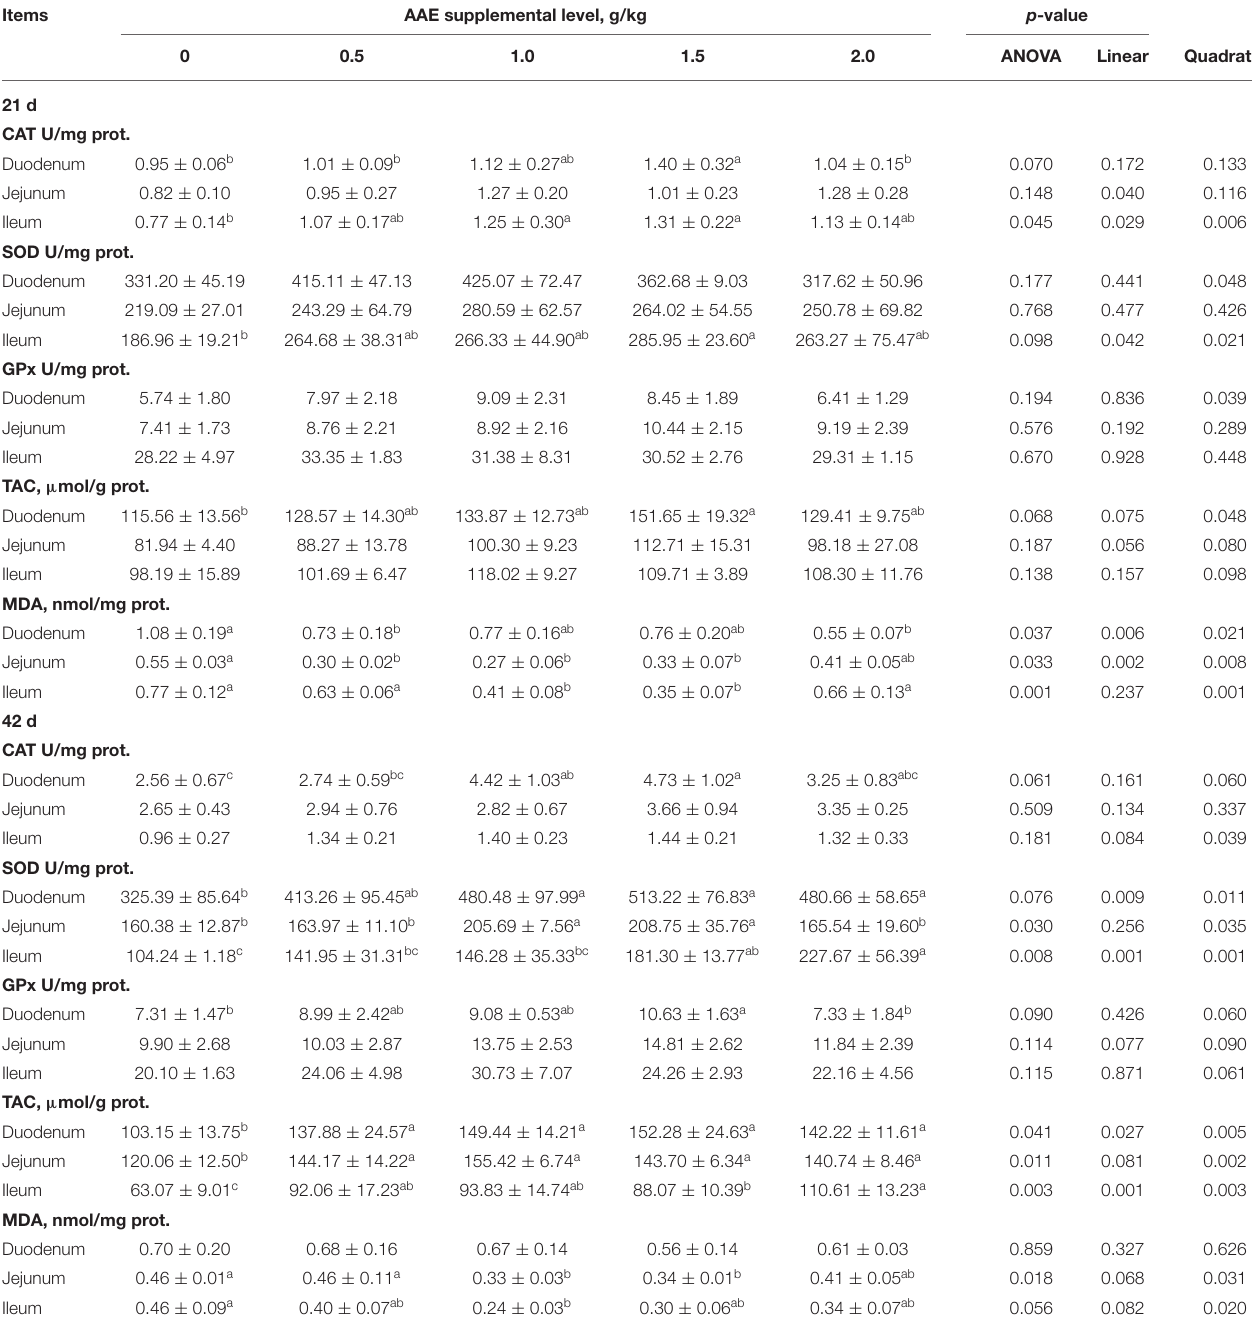
TABLE 6 | Effect of AAE on small intestine antioxidant indexes in